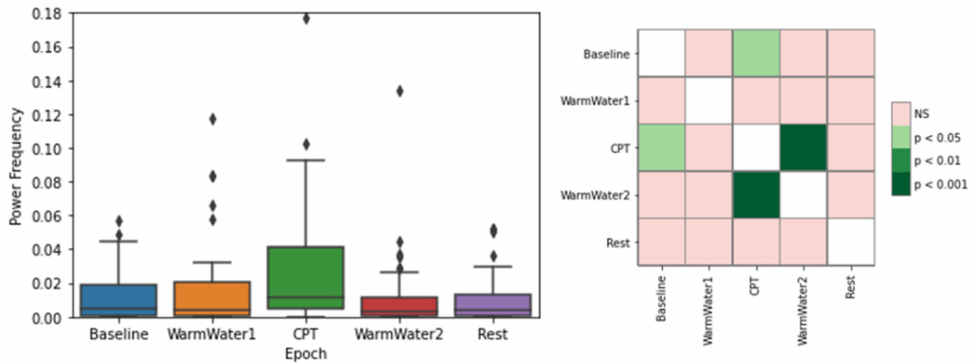
Figure 13. Boxplot of EDASymp values ( left ) and respective p -values between different epochs, with Bonferroni correction ( right ). The (cid:5) stands for